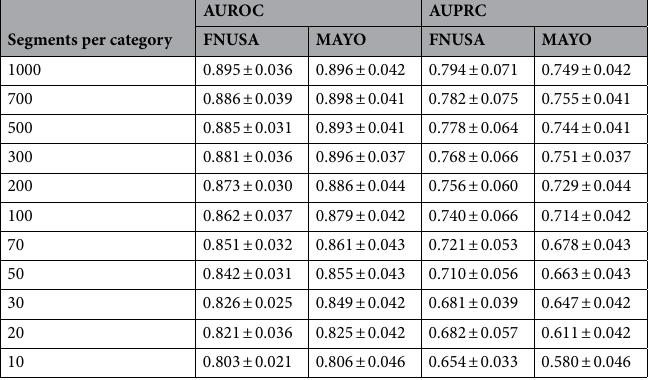
Segments per category